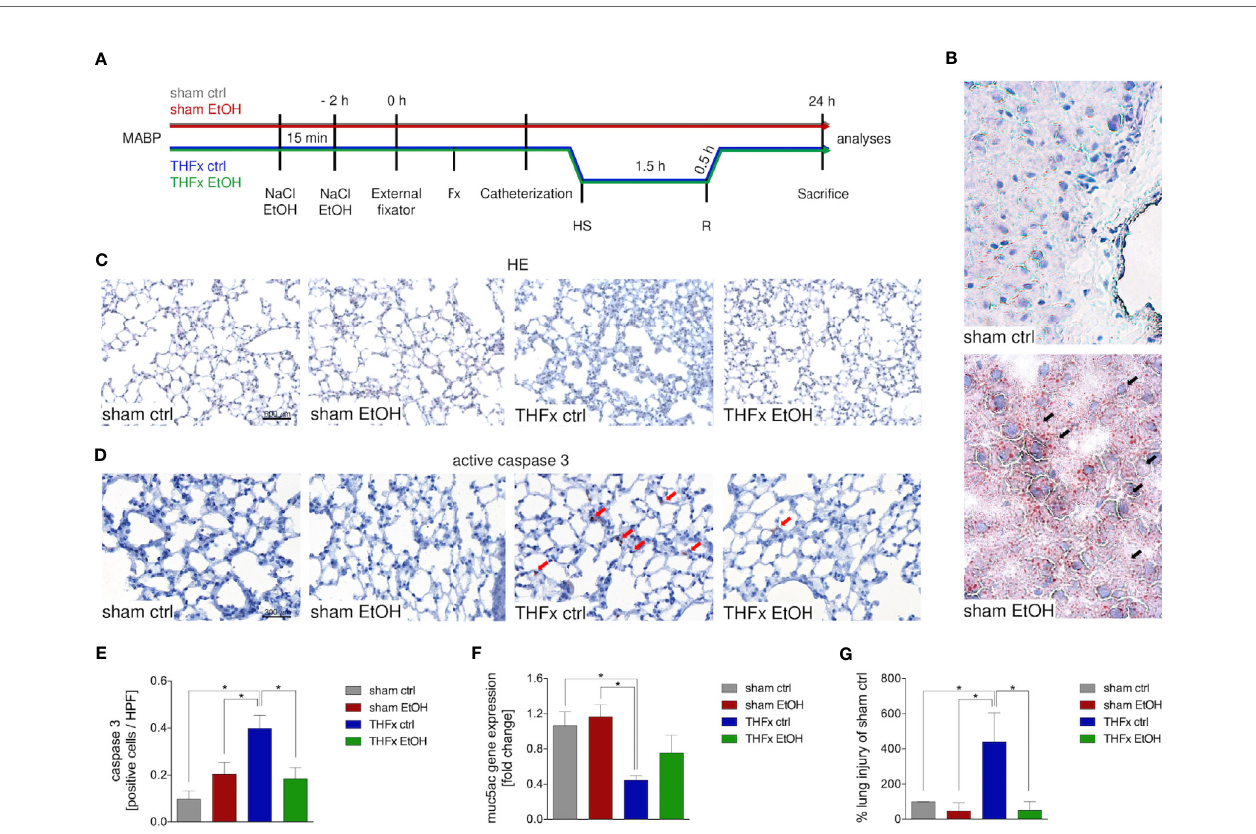
FIGURE 1 | Impact of acute ethanol intoxication (EI) on lung damage after femoral fracture (Fx) and hemorrhagic shock (HS). (A) Experimental design is shown. Two hours before the initiation of experiments, the animals received an intragastric gavage of either sodium chloride (NaCl, ctrl, n = 14) or ethanol (EtOH, n = 14) to simulate an acute intoxication with alcohol. Trauma groups underwent Fx ( via osteotomy after the placement of an external fi xator) and a pressure-controlled HS with subsequent resuscitation (R) with Ringer ’ s solution (TH) via catheterized femoral artery ( n = 14). Sham groups underwent catheterization and received an external fi xator, but THFx was not induced ( n = 14). Twenty-four hours after the end of the experiment, mice were euthanized, and sampling was performed. MABP: mean arterial blood pressure. (B) Representative oil red O staining of fatty vacuoles in hepatic tissue of mice undergoing sham procedure. Fatty vacuoles are colored red (black arrow). (C) Representative lung sections upon hematoxylin/eosin (HE) staining of the sham ctrl, sham EtOH, THFx ctrl, and THFx EtOH groups are shown. (D) Representative lung sections upon the staining of activated caspase-3 in the sham ctrl, sham EtOH, THFx ctrl, and THFx EtOH groups are shown. Exemplary caspase-3-positively stained cells are marked with red arrows. (E) Quanti fi cation of caspase 3-positively stained cells per high-power fi eld (HPF) is shown. (F) RT- qPCR with homogenized lung tissue was performed. Relative gene expression of Muc5ac normalized to Gapdh in lung tissue was calculated by using the comparative threshold-cycle 2 − DD CT method. (G) Quanti fi cation of the histopathological lung injury. The fi ndings from the sham ctrl group were used for normalization as 100%. (E, F) Data are presented as mean ± standard error of the mean; n = 7 in all groups, * p < 0.05 between indicated